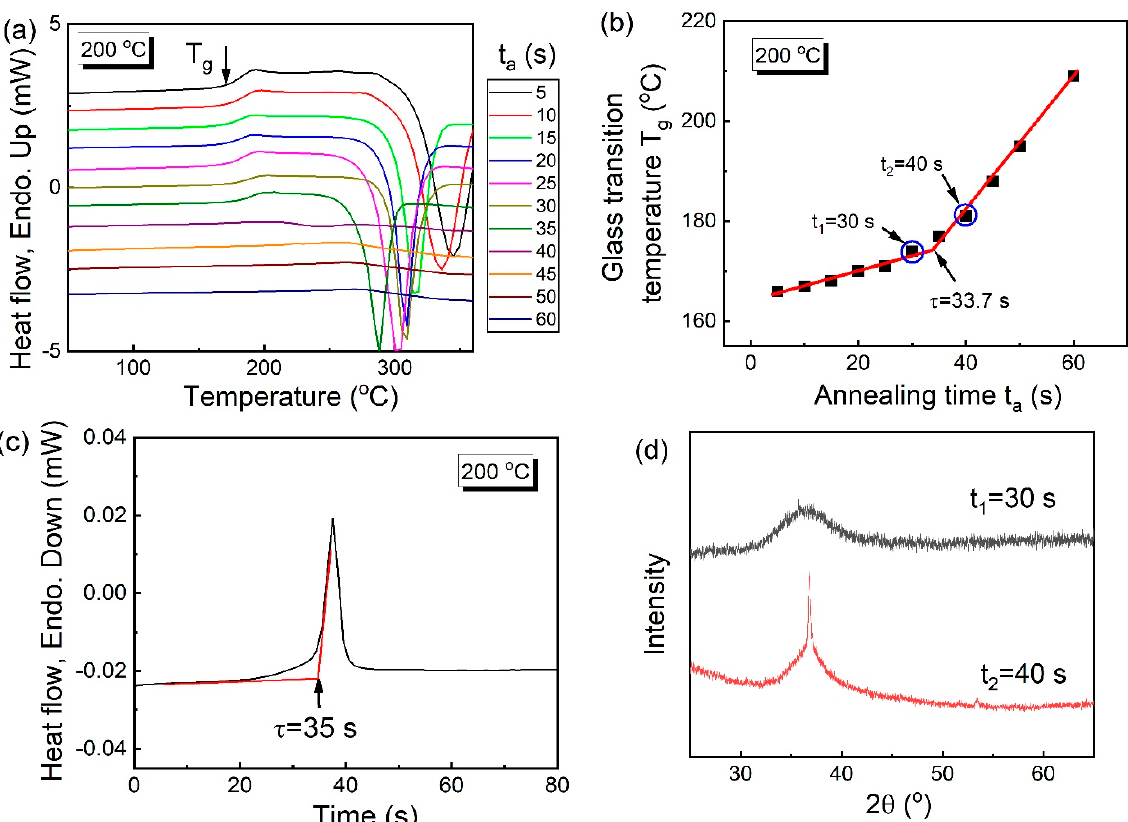
Figure 5. ( a ) A series of Flash DSC heat flow curves corresponding to different annealing times ranging t a from 5 to 60 s at 200 °C for Mg 65 Cu 25 Gd 10 MG; ( b ) plot of T g and t a at 200 °C ( t 1 and t 2 are two selected annealing times before and after break point of 33.7 s); ( c ) the isothermal test for Mg 65 Cu 25 Gd 10 MG at 200 °C; and ( d ) XRD patterns for annealed samples corresponding to the annealing times of t 1 and t 2 .